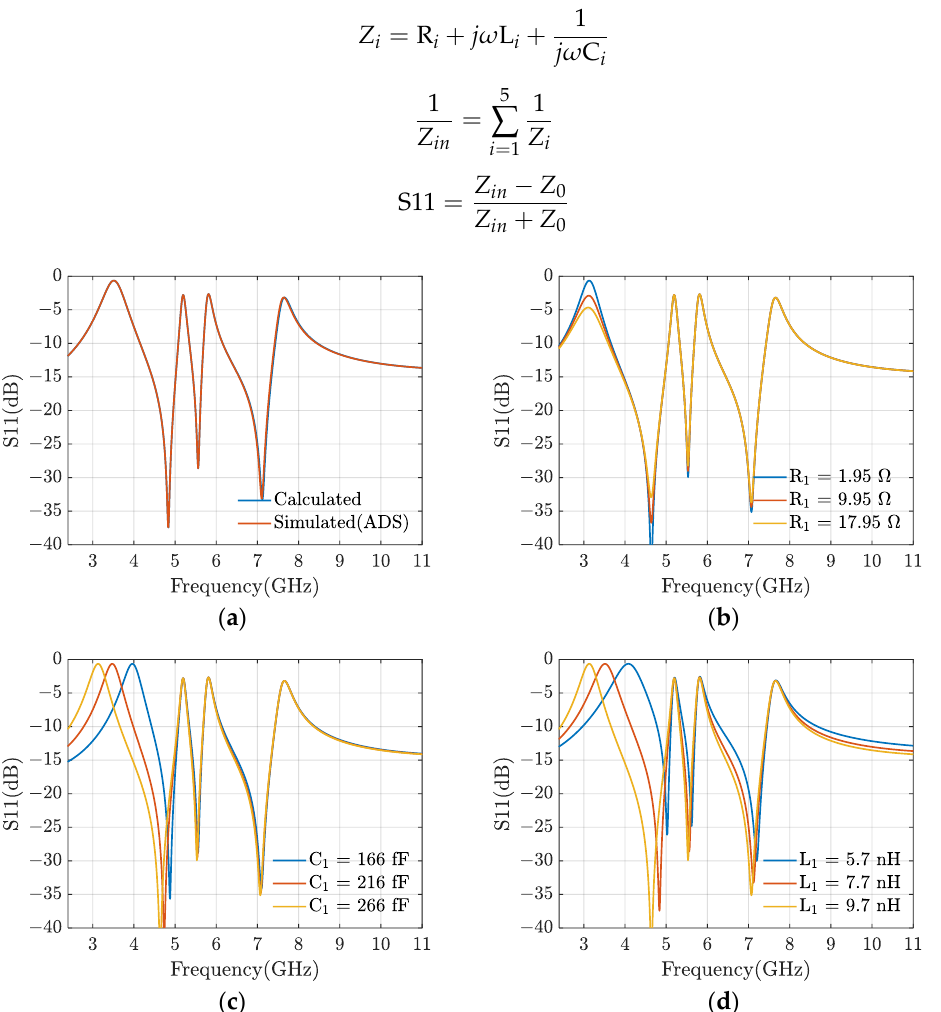
Figure 8. Simulated S11 of equivalent circuit model under different parameters. ( a ) Comparison between simulation and calculation. ( b ) Equivalent resistance R 1 . ( c ) Equivalent capacitance C 1 . ( d ) Equivalent inductance L 1